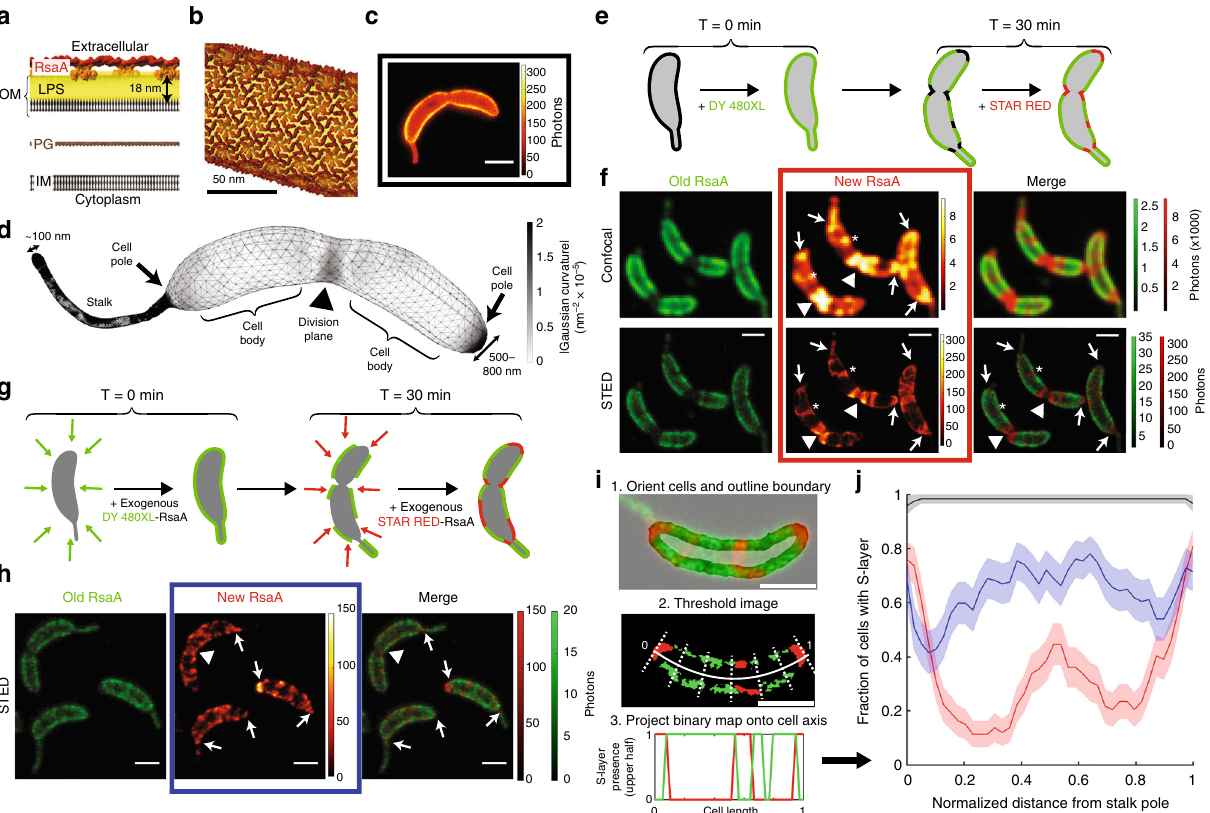
Fig. 1 Localized S-layer assembly occurs independently of secretion. a Schematic of the C. crescentus cell envelope with the S-layer crystal lattice (red/ orange) anchored to the outer membrane (OM) via an 18 nm thick LPS layer (yellow), peptidoglycan (PG), and inner membrane (IM). b Model of the RsaA S-layer structure (EMD-3604) applied to the surface of a 100 nm diameter cylinder. c STED fl uorescence microscopy image of a CysRsaA cell labeled with STAR RED. d 3D mesh representation of predivisional C. crescentus topology with absolute value of Gaussian curvature projected onto the surface (gray shading). e Schematic of 2-color pulse-chase experiment to image the sites of S-layer assembly where fl uorophores DY-480XL and STAR RED were added to CysRsaA cells 30 min apart. f Confocal (top) and STED images (bottom) show localized assembly of natively produced S-layer at the cell poles (arrows), division plane (triangles), and crack-like features on the cell body (asterisks). g Schematic of pulse-chase experiment where saturating quantities of puri fi ed, fl uorescently labeled CysRsaA are added to the media of Δ RsaA cells. h STED images show localization of newly incorporated CysRsaA protein at the cell poles (arrows), division plane (triangle), and other locations. i Overview of analysis method. Top: Cells were horizontally aligned with the stalk on the left side and the cell boundary was identi fi ed (non-gray region). Middle: S-layer was identi fi ed in both channels via intensity thresholding, and the binary image is projected along the normalized cell axis. Bottom: The projected image created two binary pro fi les of the S-layer for the upper and lower half of the cell in each color channel (red and green lines). j S-layers produced natively (red, representative cell in red boxed image Fig. 1f) or by exogenous protein addition (blue, representative cell in blue boxed image Fig. 1h) show preferential incorporation at the cell poles and division plane, while control cells (black, representative cell in black boxed image Fig. 1c) show uniform labeling. Shaded regions show 95% con fi dence intervals for n = 81, 75, and 57 cells for native, exogenous, and control cells, respectively. Scale bars = 1 μ m unless